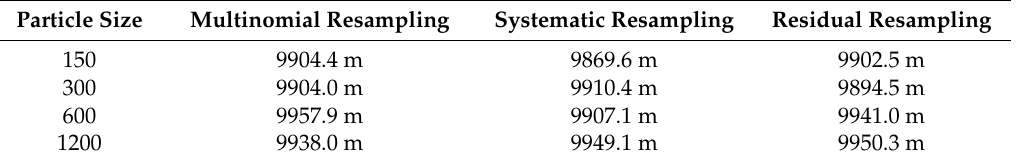
Table 2. Range estimation results in di ff erent resampling algorithms and particle sizes.